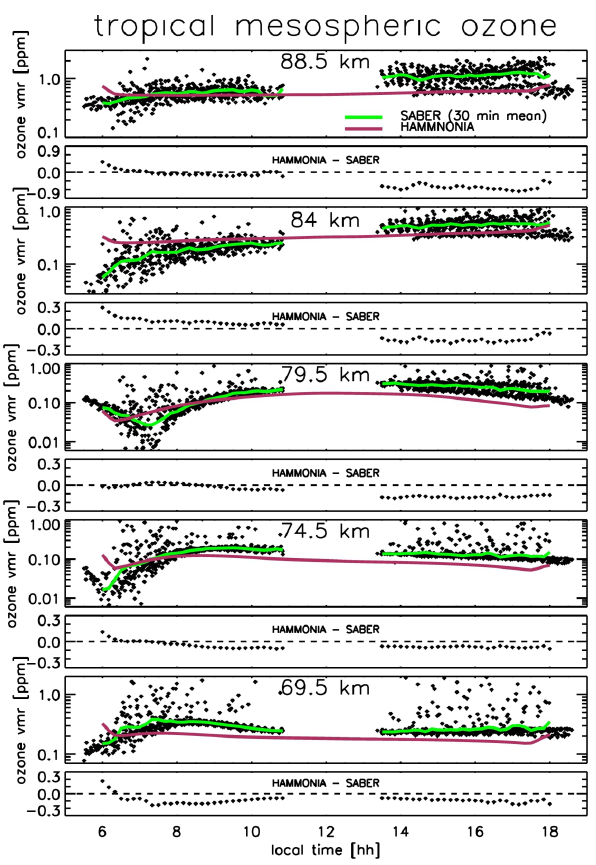
Fig. 8. Daytime ozone (1.27µm retrieval) variations as seen by SABER (dots) and HAMMONIA (red solid line) at 69.5 74.5 79.5, 84, and 88.5km (i.e. 0.03, 0.02, 0.01, 0.0061, and 0.003hPa). A 30min running mean was calculated for SABER ozone (green solid line) and the difference to HAMMONIA was plotted below each